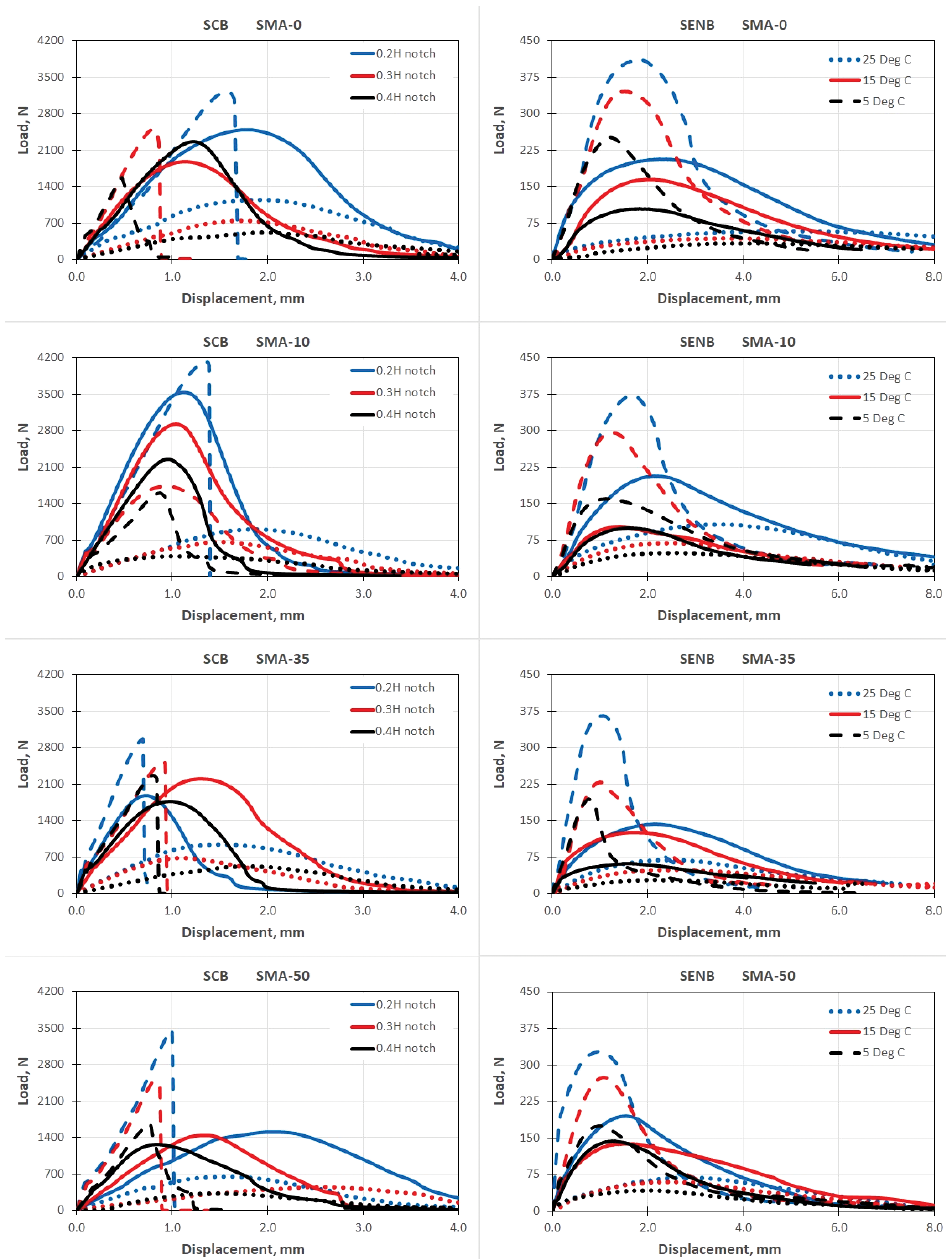
Figure 8. Load–displacement curves of SCB and SENB tests at varying notch depths and